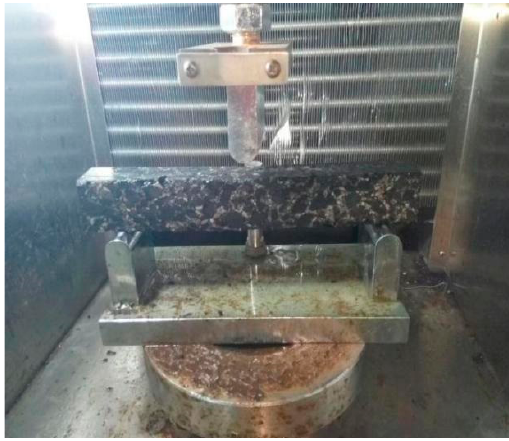
Figure 4. Low ‐ temperature bending test device.